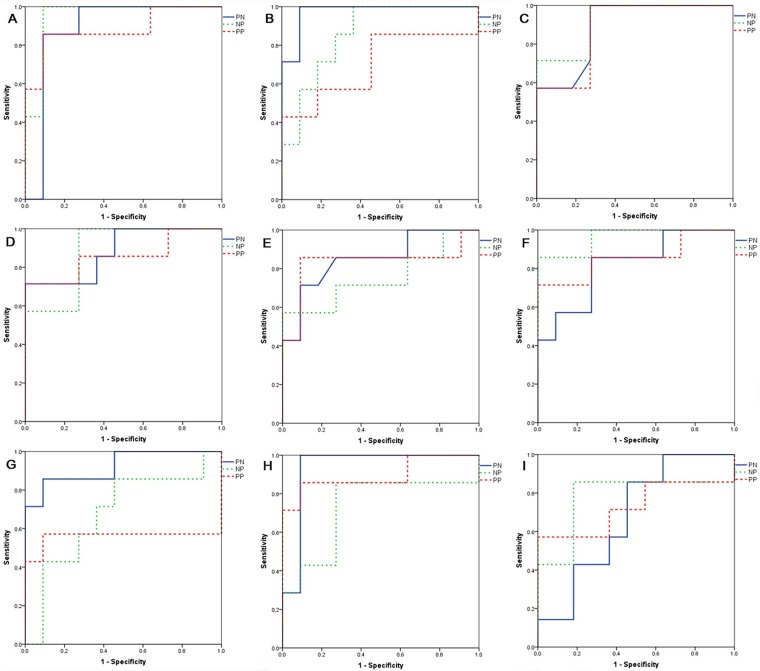
Discriminatory ability of biomarkers between infected animals and control animals.Receiver operator characteristics curves of biomarker genes in cattle infected with Mycobacterium avium subspecies paratuberculosis compared to non-infected cattle. (A) Hp; (B) Timp1; (C) Serpine1; (D) TFRC; (E) Defb10; (F) Mmp9; (G) Defb1; (H) S100a8; (I) S100a9